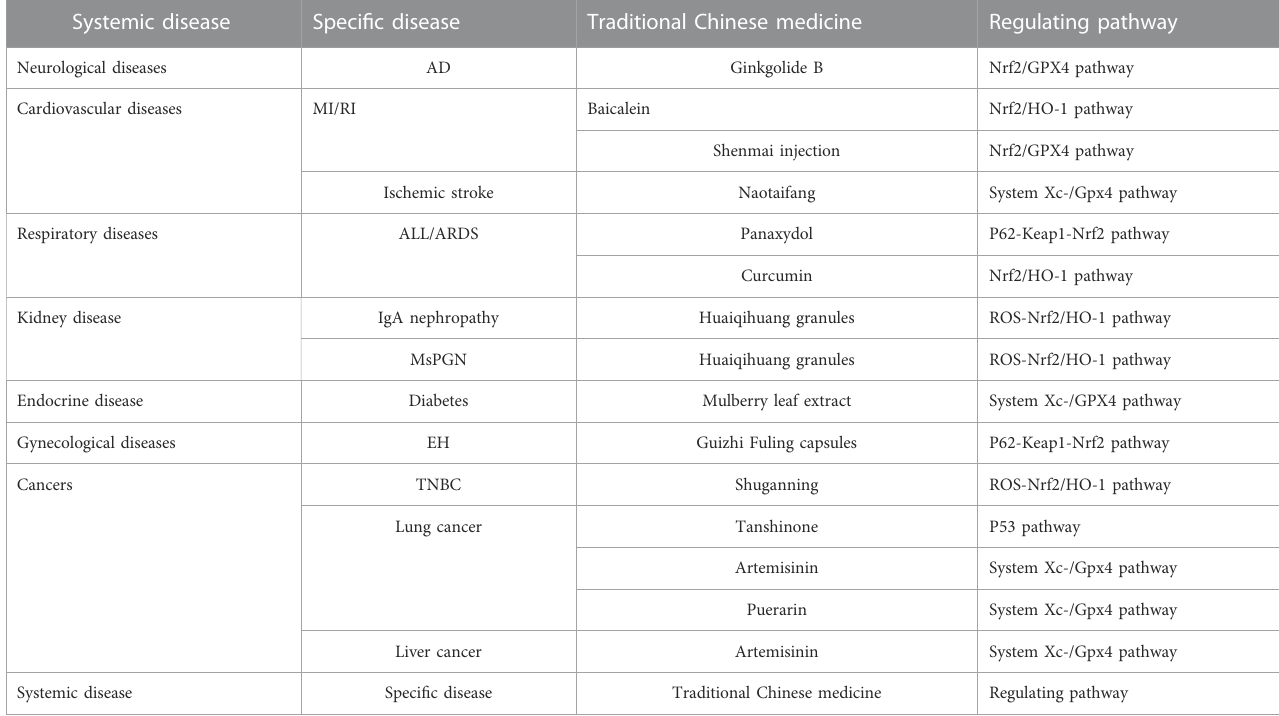
TABLE 1 Pathways regulating ferroptosis of traditional Chinese medicine in the treatment of various clinical diseases. Systemic